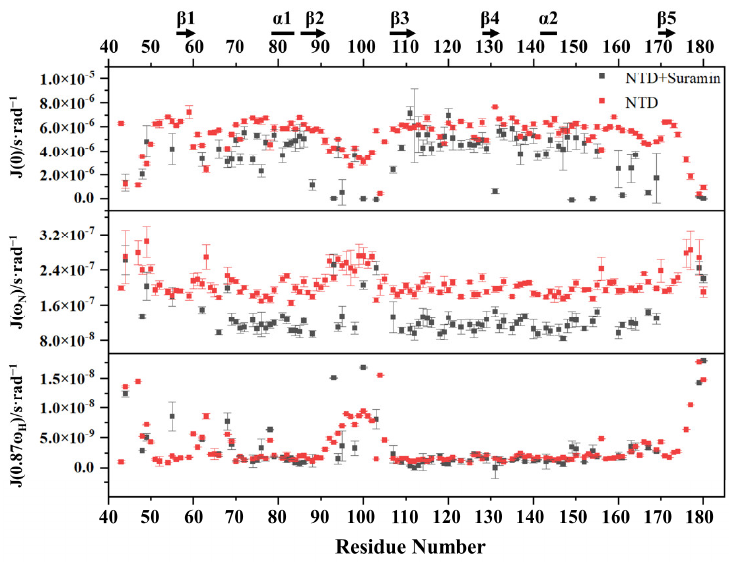
Figure 8. Calculated spectral density parameters of free N-NTD and suramin-bound N-NTD.